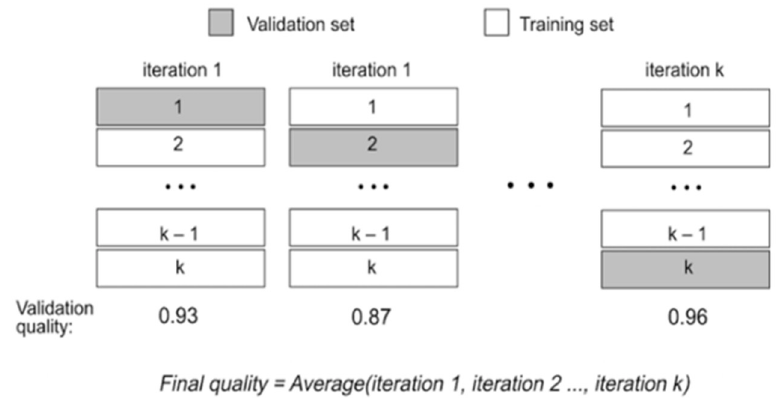
Figure 4. k -fold cross validation. Figure 4 . k -fold cross validation.